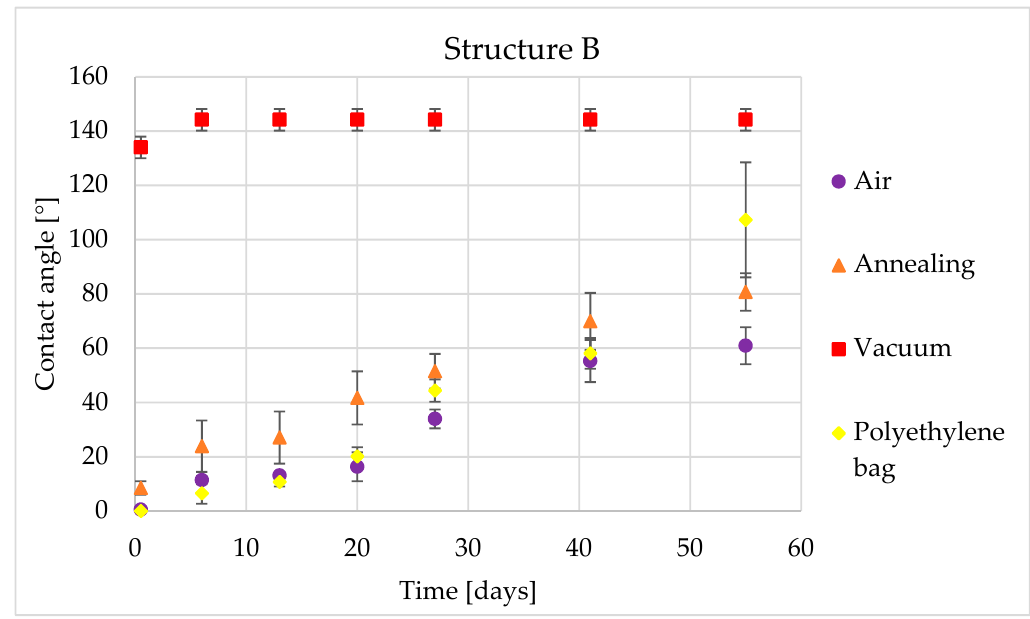
Figure 6. Time dependency of static contact angle for structure B and four types of post-processing.